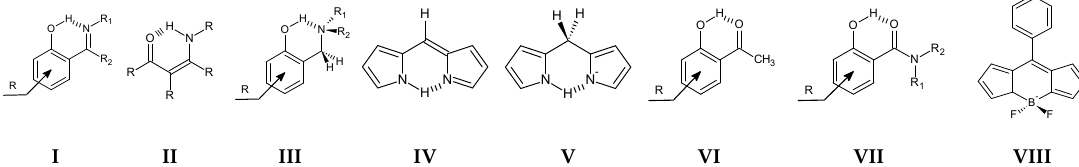
Figure 1. The structures of the hydroxyaryl Schiff bases ( I ), hydroxyalkyl Schiff bases ( II ), hydroxyaryl Mannich bases ( III ), dipyrromethene ( IV ), dipyrromethane ( V ), hydroxyl